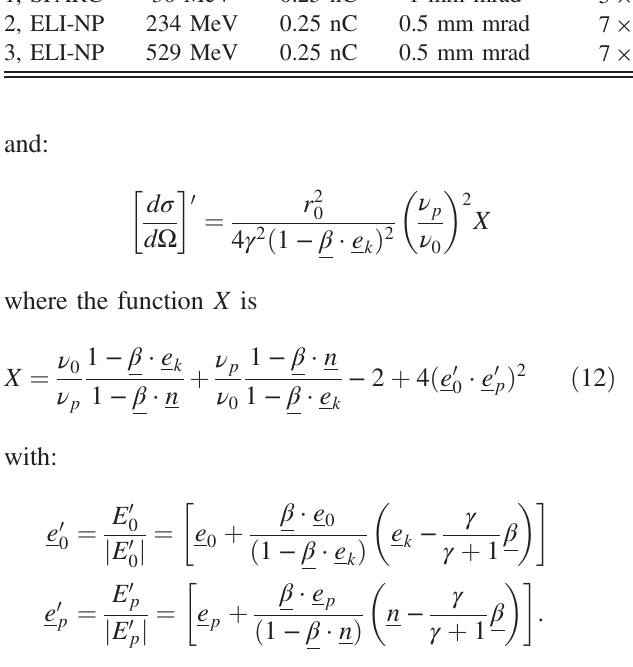
TABLE I. Electron beam, laser, and collision specifics. E e : electron beam energy, λ L : laser wavelength, E L : total laser energy, δ : complementary collision angle, w 0 : laser waist, t laser time duration, a 0 : laser parameter. Beam